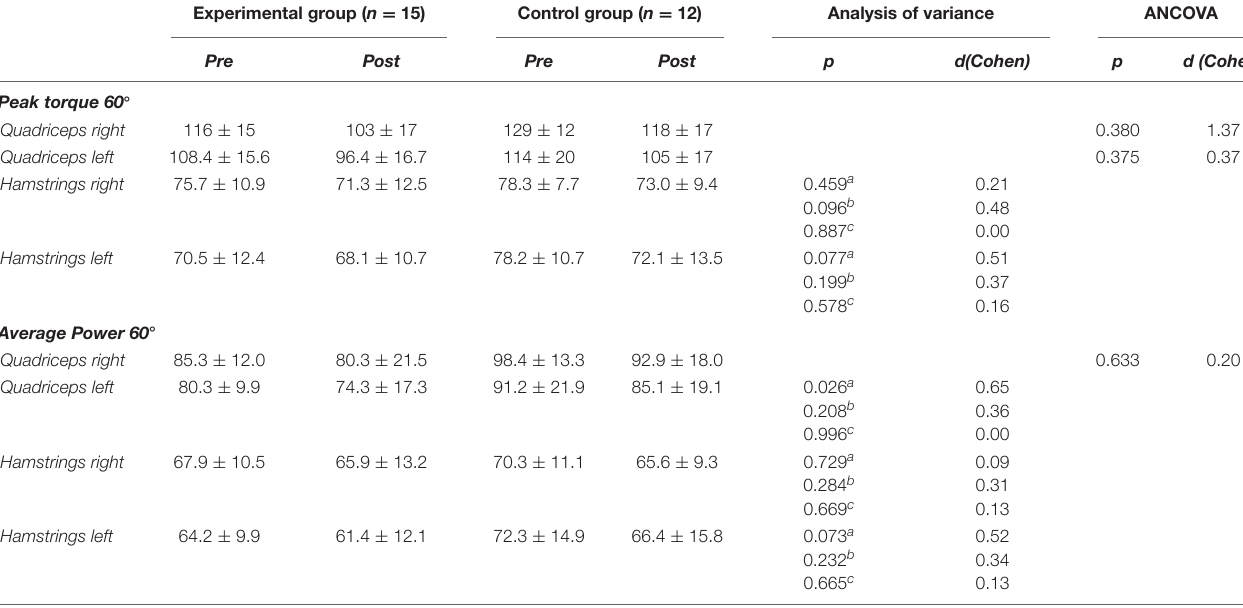
TABLE 9 | Comparison of isokinetic parameters values at 60 ◦ .s − 1 velocity between experimental and control groups before (pre) and after (post) the 8-week trial. Experimental group ( n = 15) Control group ( n = 12) Analysis of variance ANCOVA Pre Post Pre Post p d(Cohen) p d (Cohen)